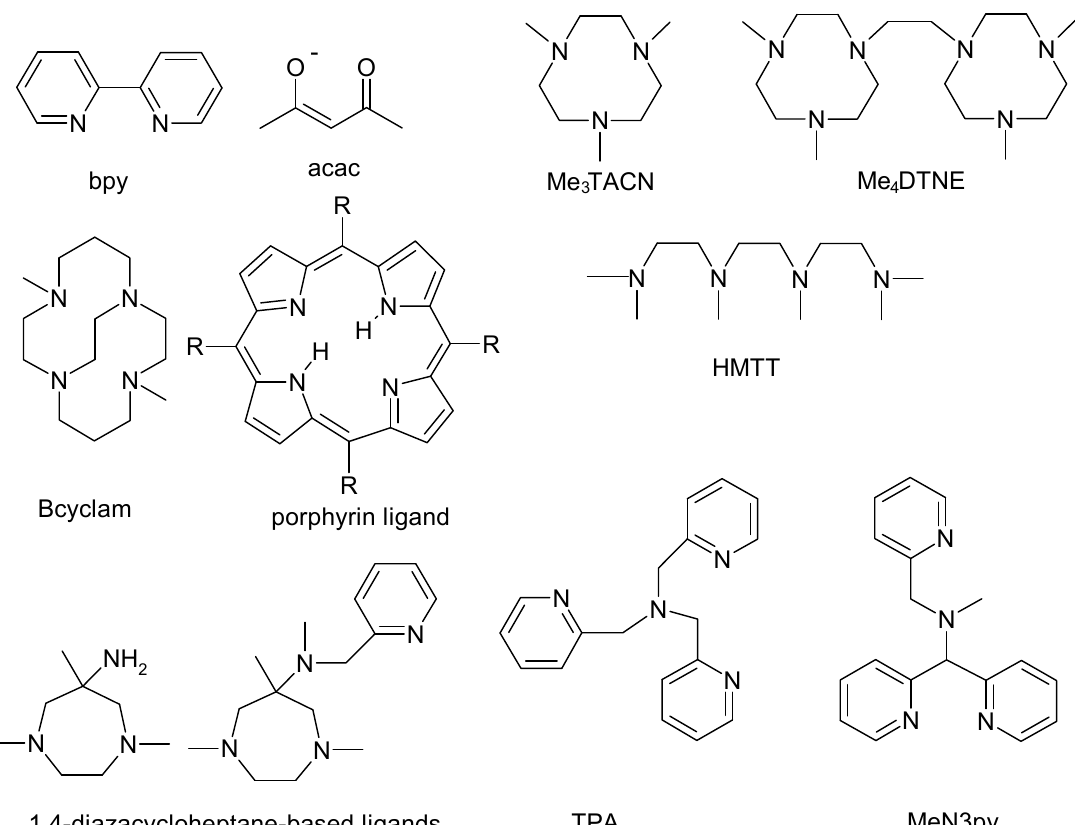
Figure 3. Ligands and additives exhibiting paint drying activity when mixed with Mn salts or as Mn- ligand complexes discussed in the text: 2,2 ′ -bipyridine (bpy), acetylacetonate (acac), 1,4,7-trimethyl- 1,4,7-triazacyclononane (Me 3 TACN), 1,2-bis(4,7-dimethyl-1,4,7-triazacyclononan-1-yl)-ethane (Me 4 DTNE), 4,11-dimethyl-1,4,8,11-tetraazabicyclo[6.6.2]hexadecane (Bcyclam), 5,10,15,20- tetrakisphenylporphyrin (R = phenyl; porphyrin ligand), N , N , N ′ , N ″ , N ′′′ , N ′′′ - hexamethyltriethylenetetraamine (HMTT), 6-amino-1,4,6-trimethyl-1,4-diazacycloheptane and 1,4,6- trimethyl-6{ N -pyridin-2-ylmethyl)- N -methylamino}-1,4-diazacycloheptane (1,4-diazacycloheptane based ligands), tris(pyridin-2-ylmethyl)amine (TPA), and N-methyl-N(pyridin-2-ylmethyl)- bis(pyridin-2-yl)methylamine (MeN3py).